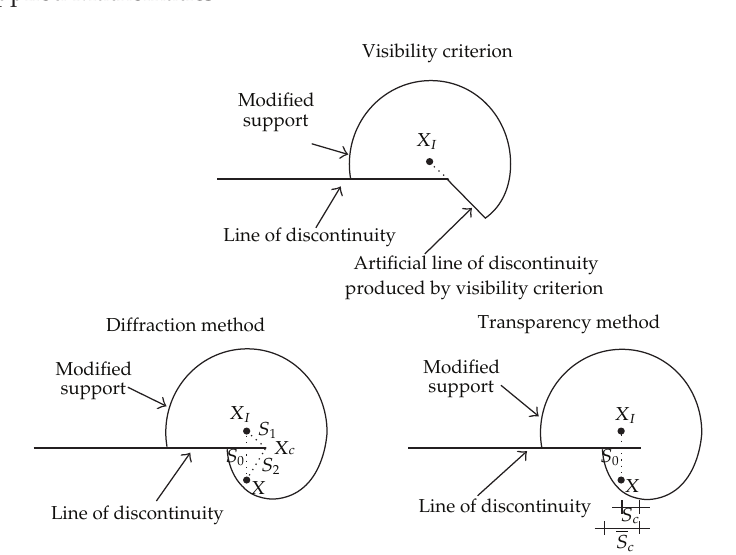
Figure 1: Visibility criterion, di ff raction, and transparency method for the treatment of discontinuities (cid:6) 11 (cid:7) .